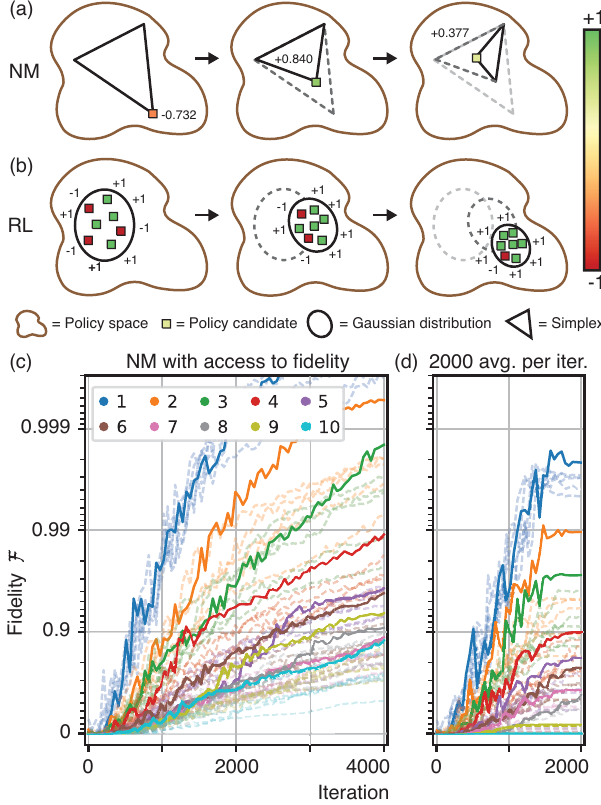
FIG. 7. Preparation of Fock states j 1 i ; … ; j 10 i with the NM simplex search. (a) Cartoon depiction of the NM simplex search. One algorithm iteration corresponds to an update of one vertex of a simplex. The color-coded values of the cost function have high resolution, achieved through averaging of many (cid:3) 1 measurement outcomes. (b) Cartoon depiction of our RL approach. Every training epoch consists of several episodes executed with differ- ent policy candidates that are sampled from a Gaussian distri- bution. Policy candidates are assigned a low-resolution reward of (cid:3) 1 based on a single measurement outcome instead of averaging. (c) NM optimization progress with infidelity used as a cost function. The background trajectories correspond to six random seeds for each state, and solid lines show the trajectory with the highest final fidelity. (d) NM optimization progress with a stochastic cost function obtained by averaging 2000 outcomes of the Fock reward circuit shown in Fig.